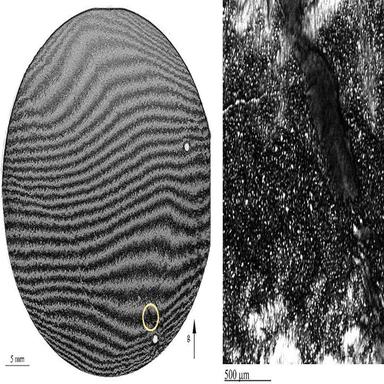
Grazing topograph from the Ga face of a regular HVPE GaN wafer and a magnified area marked by a bright circle showing a uniform distributed but high density of dislocations (>106 cm− 2 ).